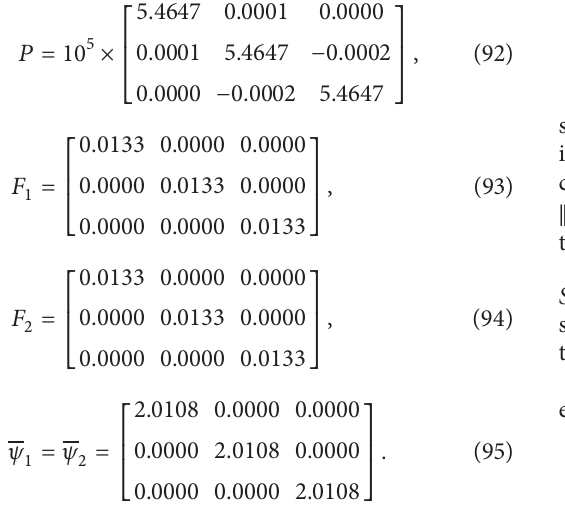
Figure 10: State responses of both master and slave